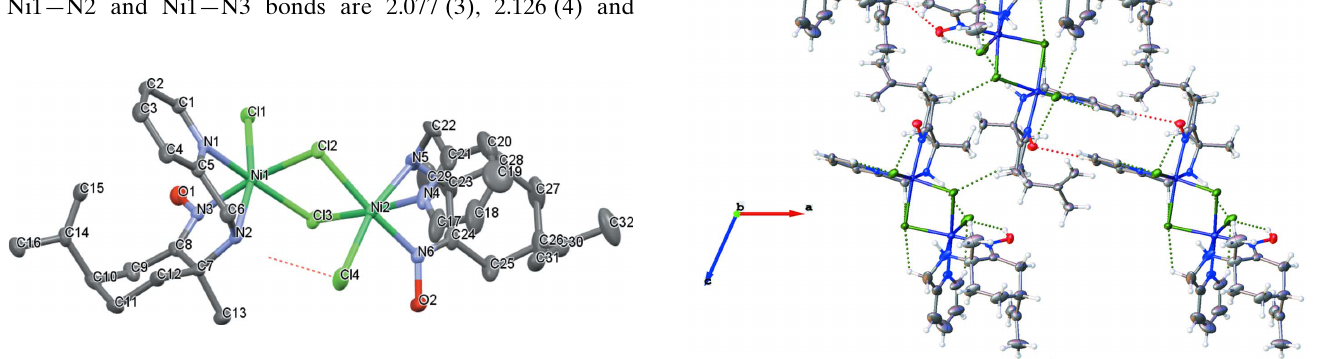
Figure 2 Intermolecular and intramolecular hydrogen bonds in the structure, shown as dashed